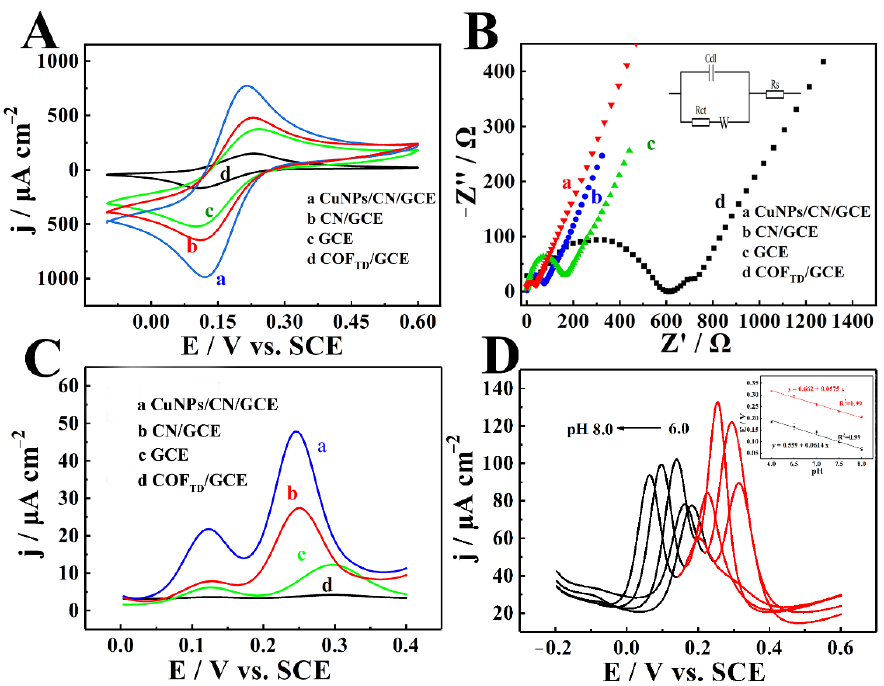
Figure 4. ( A ) CVs and ( B ) EIS of CuNPs/CN/GCE, CN/GCE, GCE, COF TD /GCE in 0.1 M KCl solution containing 5 mM [Fe(CN) 6 ] 3 − /4 − (scanning rate of 50 mV s − 1 for CVs). Inset in Figure 4B Randles circuit model. ( C ) DPV of CuNPs/CN/GCE, CN/GCE, GCE, COF TD /GCE in 0.2 M PBS (pH = 7) containing 10 µ M DA and 50 µ M UA. ( D ) DPV of CuNPs/CN/GCE in 0.2 M N 2 -satruated PBS with different pH from 6.0 to 8.0 containing DA and UA (Inset: fitting curve between Ep and pH).